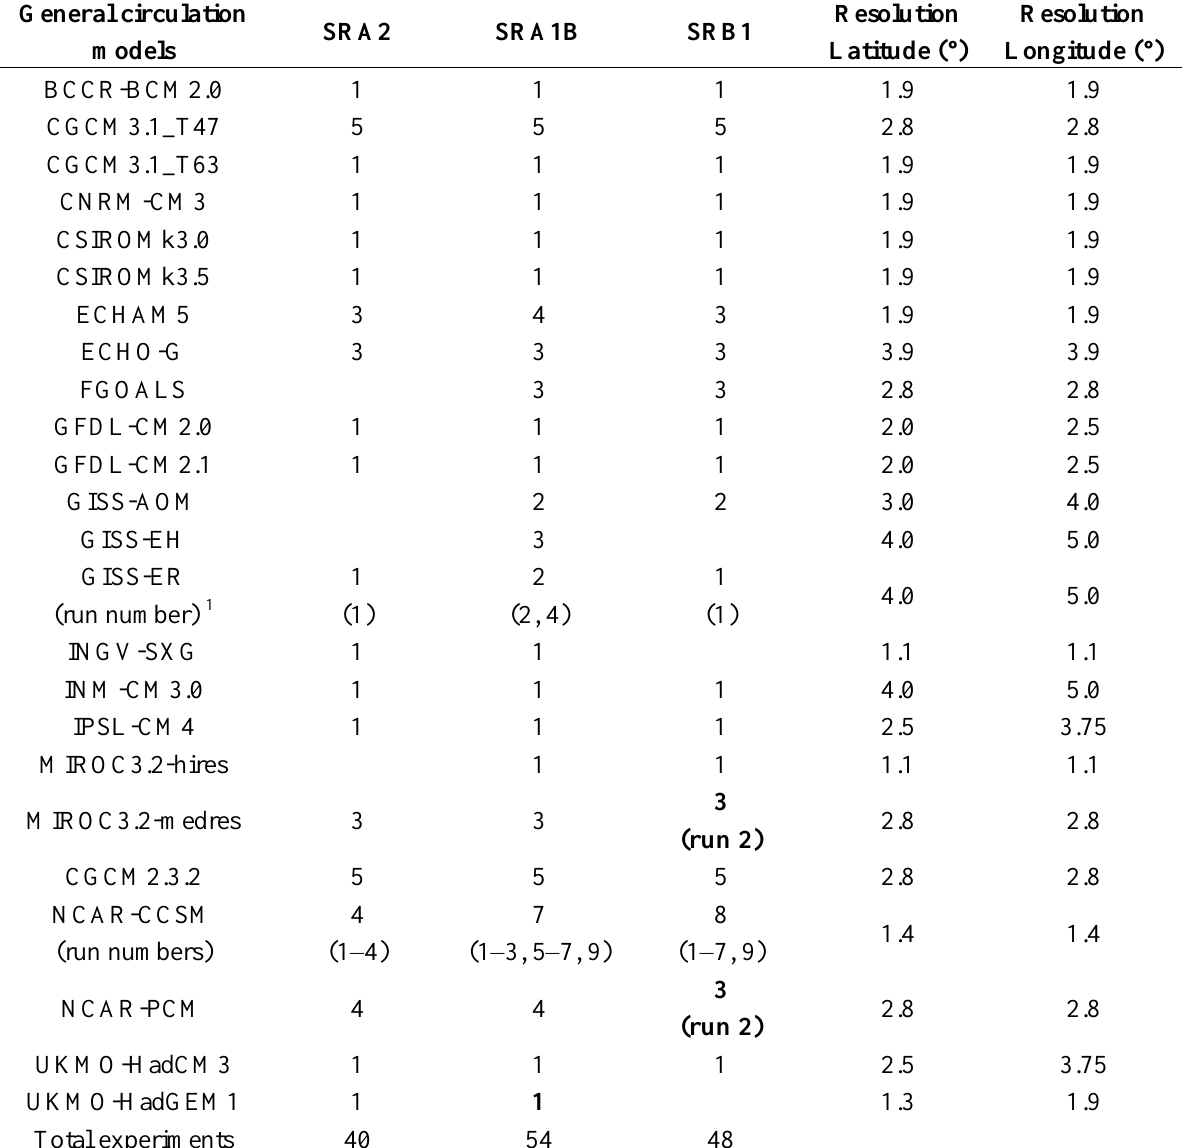
Models and emissions scenarios to select future median and extreme climate scenarios for the Canadian